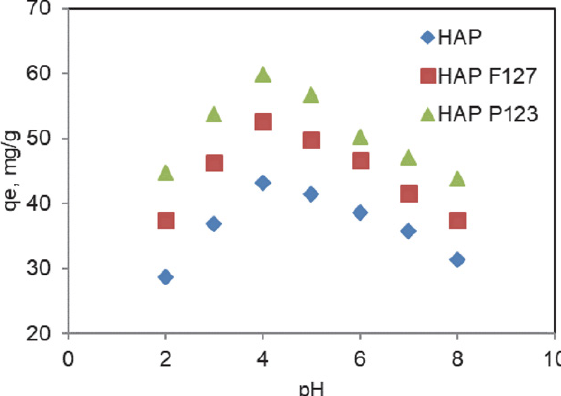
Figure 4. Influence of pH values on the adsorption process of Al(I- III)